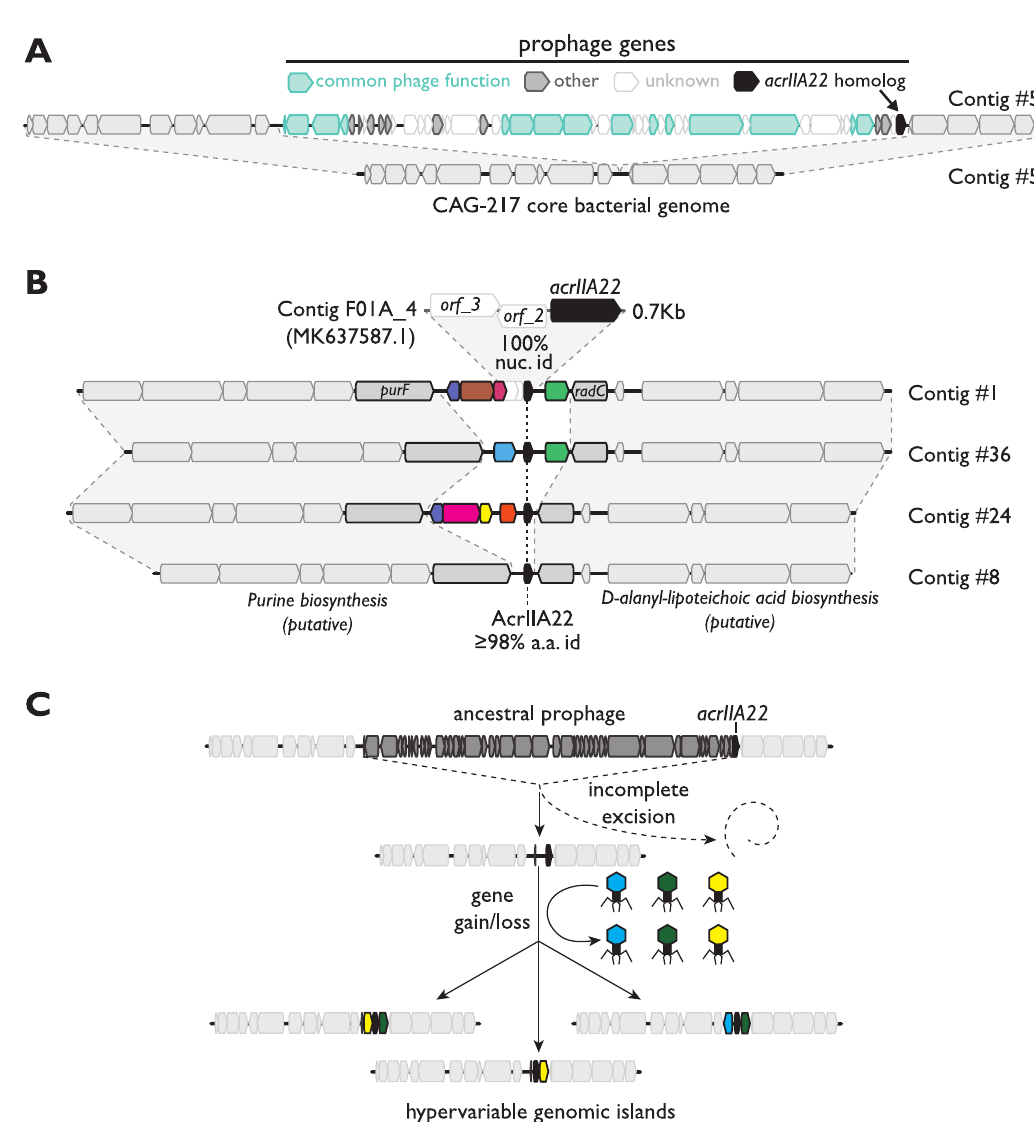
Fig 2. AcrIIA22 homologs are found in hypervariable regions of prophage and bacterial genomes in the unnamed clostridial genus, CAG-217. ( A ) We show a schematic representation of an acrIIA22 homolog embedded in a prophage genome, which is integrated into a bacterial genome (contig #57). We can delineate precise boundaries of the inserted prophage based on comparison to a near-identical bacterial contig (contig #55). Prophage genes are colored by functional category, according to the legend at the top. Bacterial genes are colored light gray. ( B ) Homologs of acrIIA22 are depicted in diverse genomic islands, including Contig #1, whose sequence includes a portion identical to F01A_4, the original metagenomic contig we recovered. All acrIIA22 homologs in these loci are closely related, but their adjacent genes are different, unrelated gene families (depicted by different colors). Genomic regions flanking these hypervariable islands, including genes immediately adjacent to these islands ( purF and radC , in bold outlines), are nearly identical to one another ( � 98% nucleotide identity). Contigs are numbered to indicate their descriptions in S3 Table, which contains their metadata, taxonomy, and sequence retrieval information. All sequences and annotations may also be found in S2 and S3 Data. ( C ) We propose an evolutionary model for the origin of the acrIIA22 -encoding hypervariable genomic islands depicted in panel B. We propose that acrIIA22 moved via prophage integration into a bacterial genomic locus but remained following an incomplete prophage excision event. Its neighboring genes subsequently diversified via horizontal exchange with additional phage genomes without these phage genomes inserting into the locus. S4 Fig depicts a more detailed version of the genomic data underlying this model.